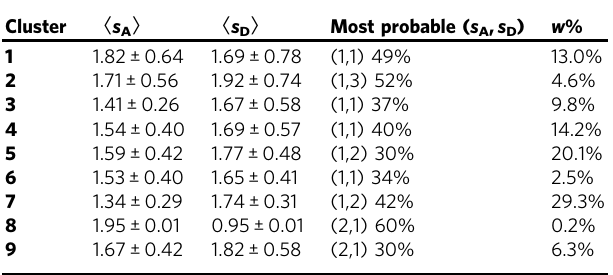
〈 s D 〉 and 〈 s A 〉 denotes the weighted averaged number of donated and accepted NH ⋯ O and its standard deviation. w quanti fi es the weight of each cluster with respect to the relative population of each cluster to the total number of conformers found in the REMD trajectory at 300K. Most probable (two-dimensional) H-bonding con fi gurations are given as tuples along with their joint probability.